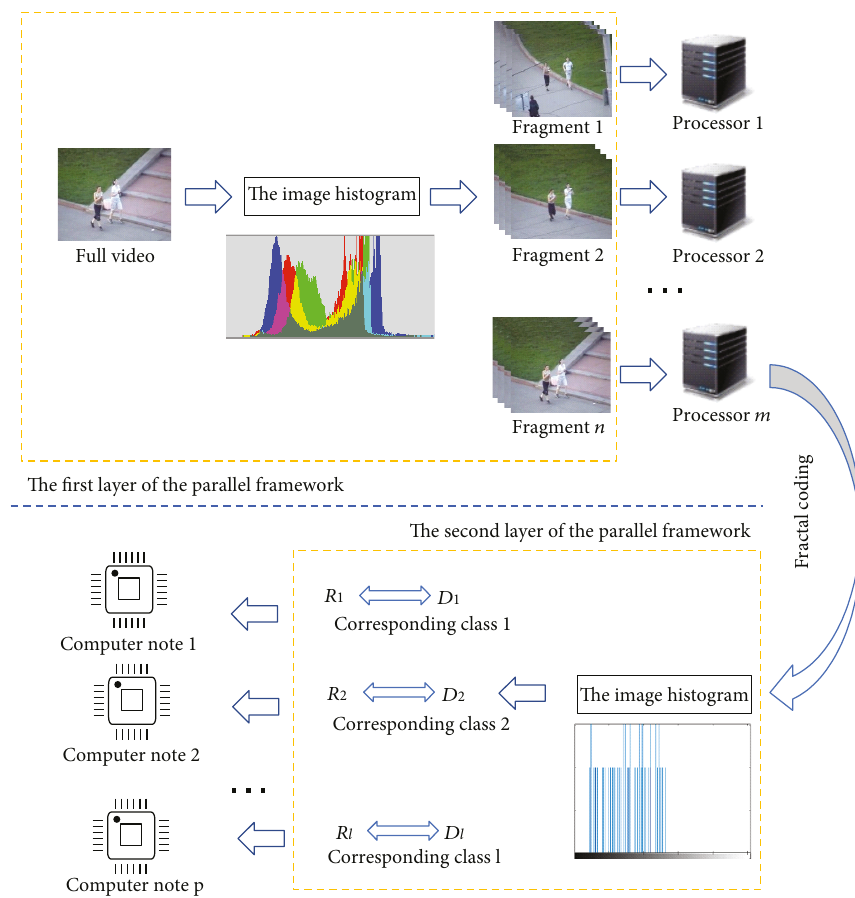
Figure 5: Parallel